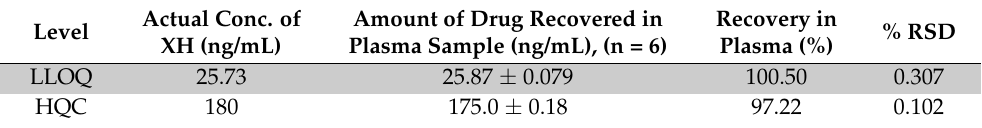
Table 1. Results of matrix effect.